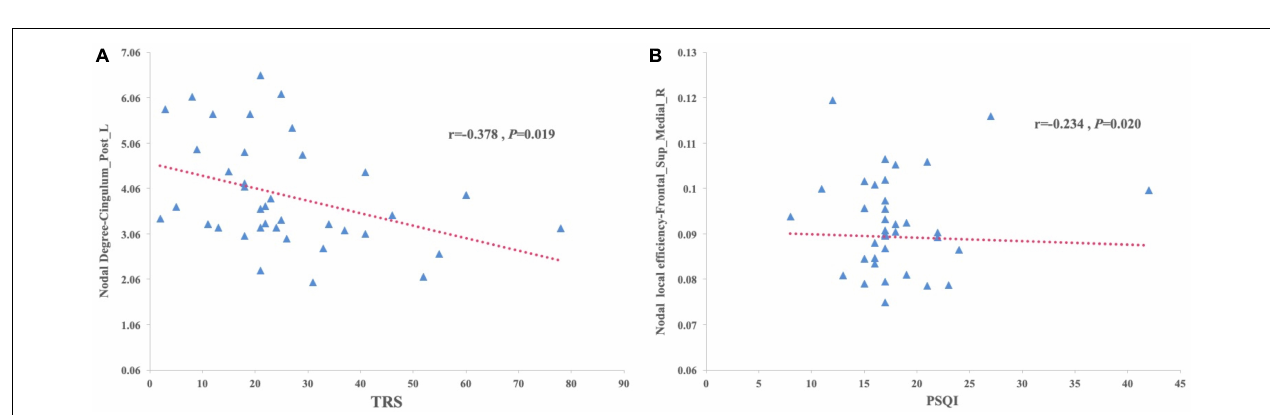
FIGURE 2 | Schematic of functional connectome with significant differences, SleET, NorET with HC; between SleET and HCs, and between NorET and HC, respectively. Note that the A(1–3) connected network with F-statistic (one-way ANOVA, T = 2.85, p = 0.001) contains 11 nodes and 32 connections; the B(1–3) connected network with a T-statistic ( T = 1.76, p = 0.014) contains 6 nodes and 15 connections; and the C(1–3) connected network with a T-statistic ( T = 1.60, p = 0.008) contains 7 nodes and 15 connections. All the connections were decreased in patient subgroups compared with HCs. SleET Essential tremor with poor sleep quality; NorET, Essential tremor with normal sleep quality; HC, Healthy controls; SFGdor.L left superior frontal gyrus, dorsolateral; SFGmed.L(R) left/right superior frontal medial gyrus; PCG.L(R) left/right posterior cingulate gyrus; LING.L(R) left/right lingual gyrus; SOG.L(R) left/right superior occipital gyrus; MOG.L left middle occipital gyrus; FFD.R right fusiform gyrus; CRBL6.R right superior cerebellum.